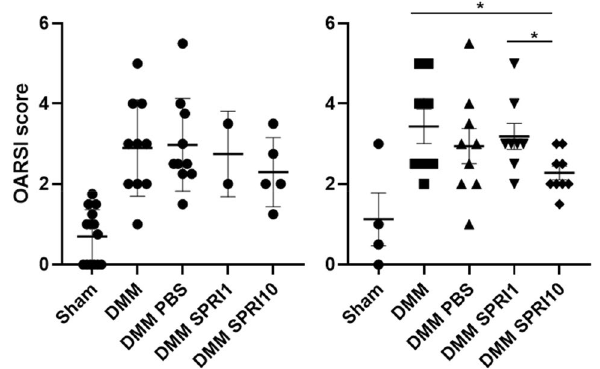
Figure 5. OARSI scores of Shams, DMM, DMM + PBS, DMM SPRI1 and DMM SPRI10 at 12 W (left) and 24 W (right) after surgery. Results are mean ± SEM. *p < 0.05 for DMM SPRI10 versus DMM SPRI1 and DMM.